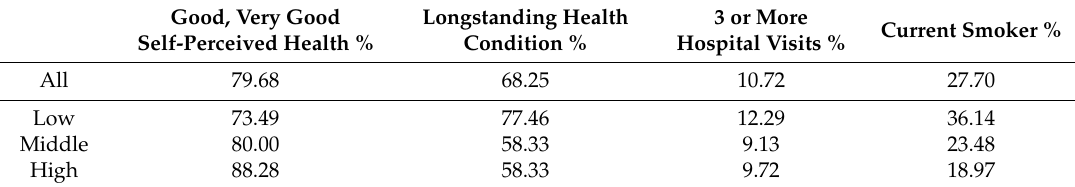
Table 1. Health outcomes by self-perceived social status (low, middle, high).